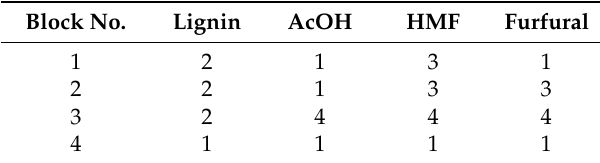
Table 2. Optimal number of PLS components in block 1 to 4 for the components lignin, acetic acid, HMF, and furfural of the raw data derived by rdCV.